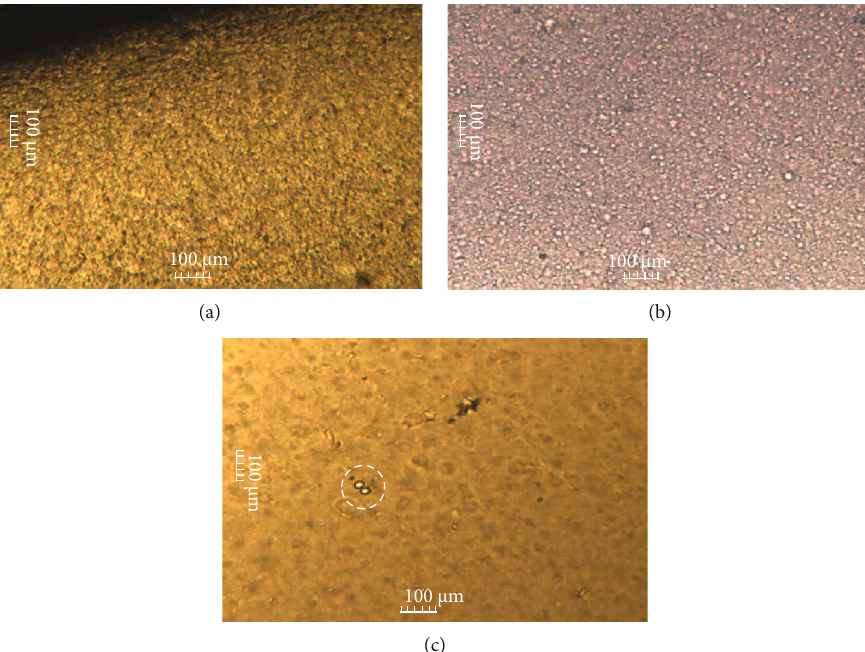
Figure 6: Optical micrographs of (a) HPC/PAAm gel, (b) HPC/PAAm gel with acetaminophen, and (c) HPC/PAAm gel with acetaminophen after 24 hours of swelling in